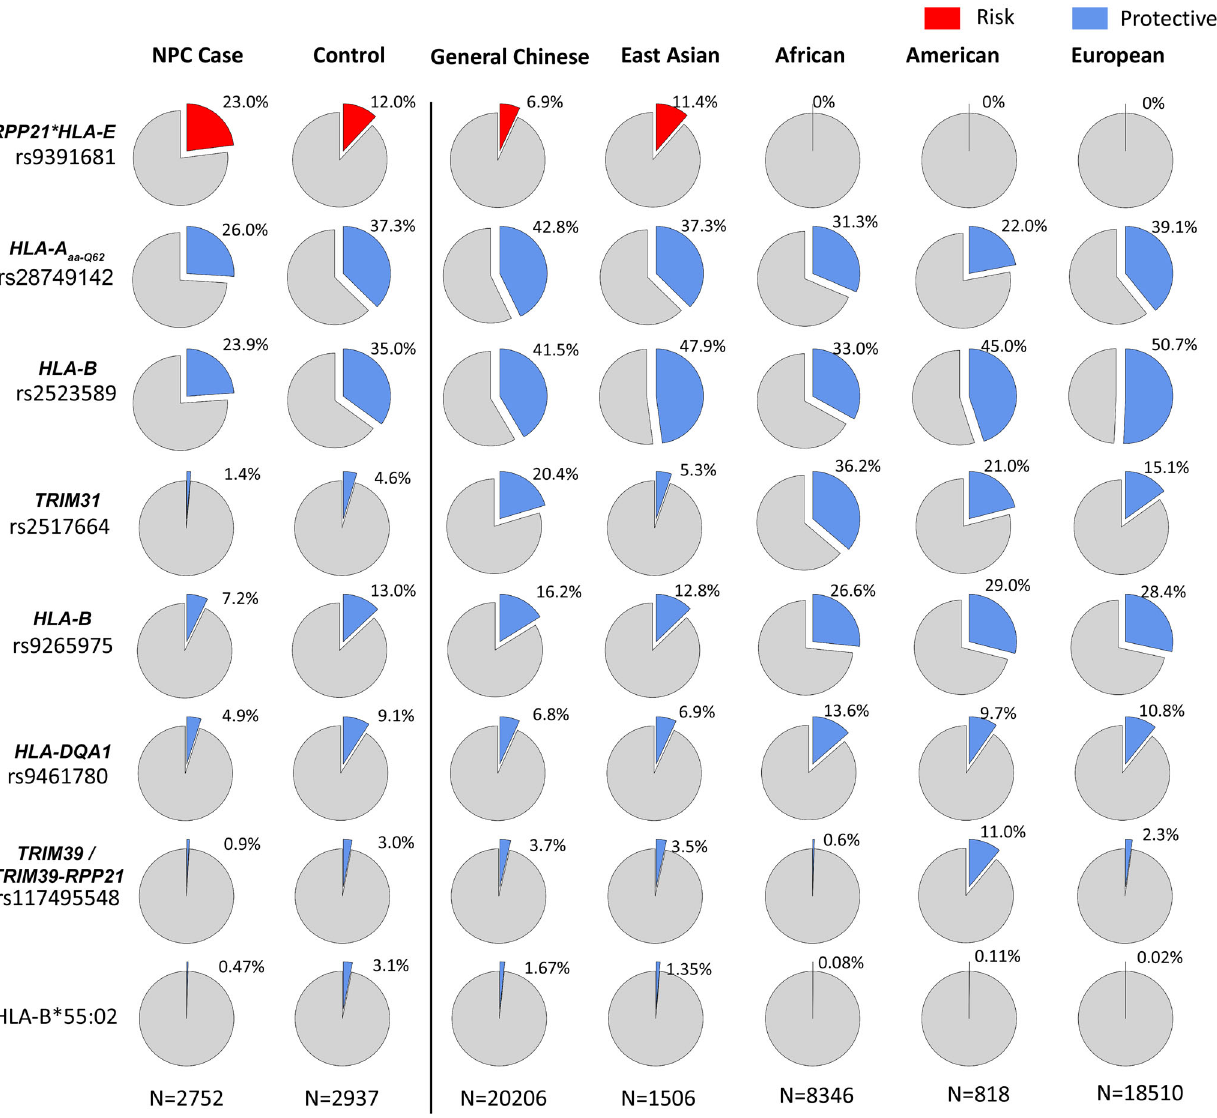
Fig. 3 Comparison of the MAF of eight independent associated signals in NPC across different ethnic populations. The other ethnic populations included East Asian, African, American, European, and Ashkenazi Jews from the gnomAD database and a general Chinese cohort from a psoriasis study 25 . The NPC susceptibility allele is in red, while the multiple NPC protective alleles are in blue. The MAF of the susceptibility rs9391681 for NPC is higher in Hong Kong Chinese and East Asians but extremely rare in the four other non-Asian populations from the gnomAD database. The MAFs of rs2523589, rs9265975, rs2517644, rs9461780, and rs117495548 for NPC are much lower in Hong Kong Chinese and East Asians than other non-Asian populations. Rs28749142 is a tagging SNP of HLA-A aa-Q62 ( R 2 = 0.95) . The MAF of rs28749142 does not occur as often in Hong Kong Chinese and East Asians, as compared to general Chinese and European populations. HLA-B*55:02 allele frequencies are obtained from the Allele frequency net database (http://www. allelefrequencies.net) for European, North American, South East Asian populations. HLA-B*55:02 allele is more prevalent in Chinese and East Asian